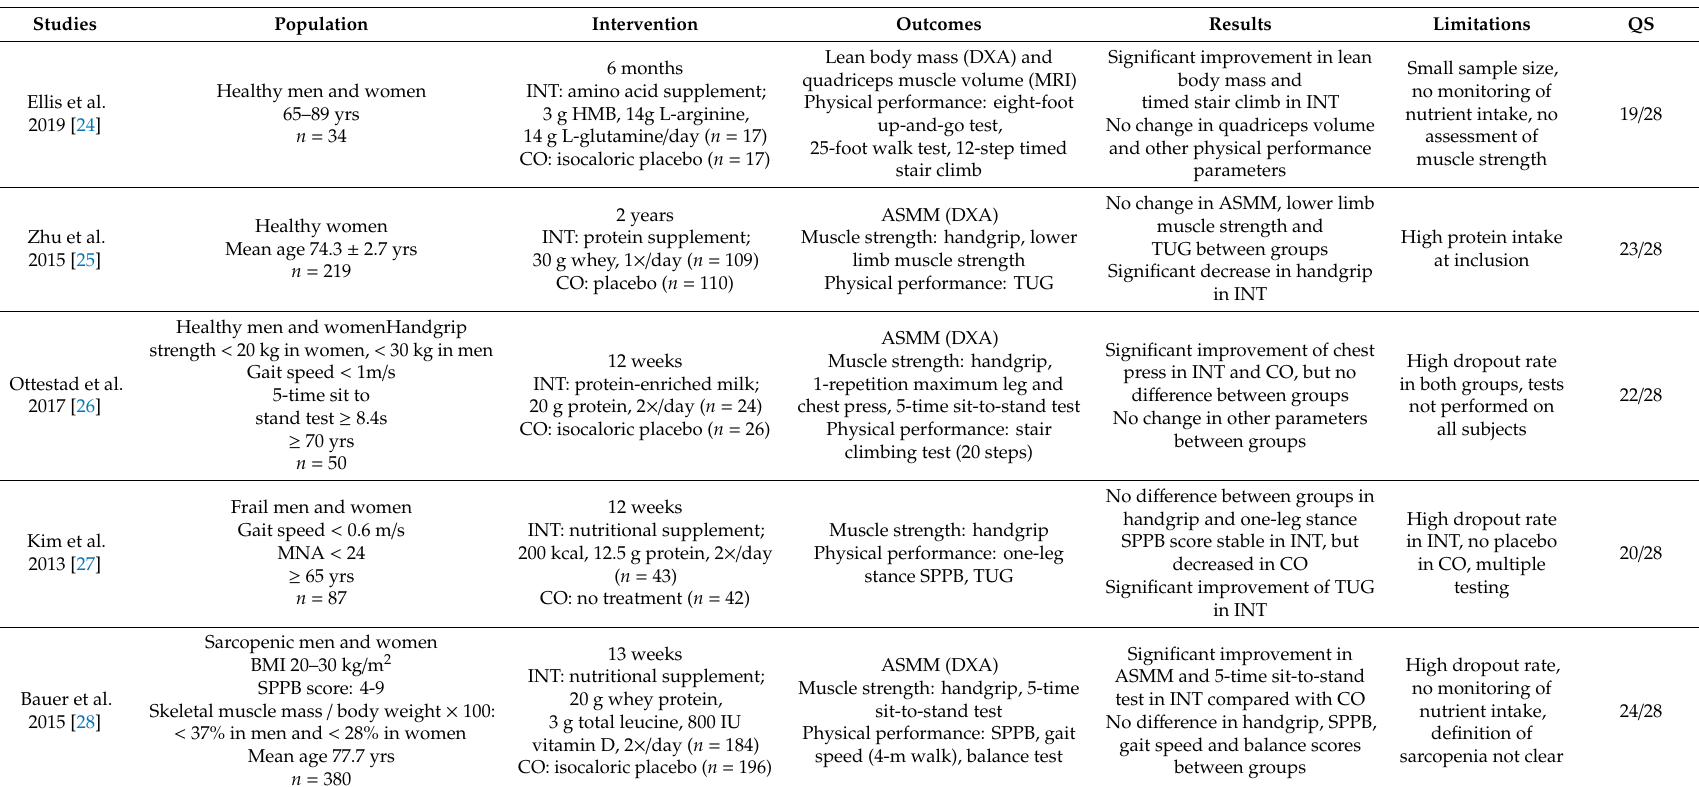
Table 1. Unimodal nutritional interventions in community-dwelling older